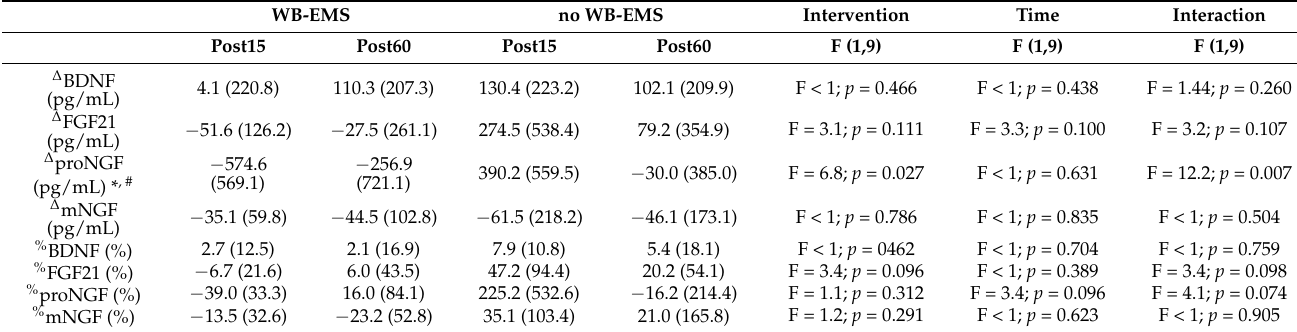
Table 4. Neurotrophic factors comparison ( ∆ scores). Data are mean and SD and percentage